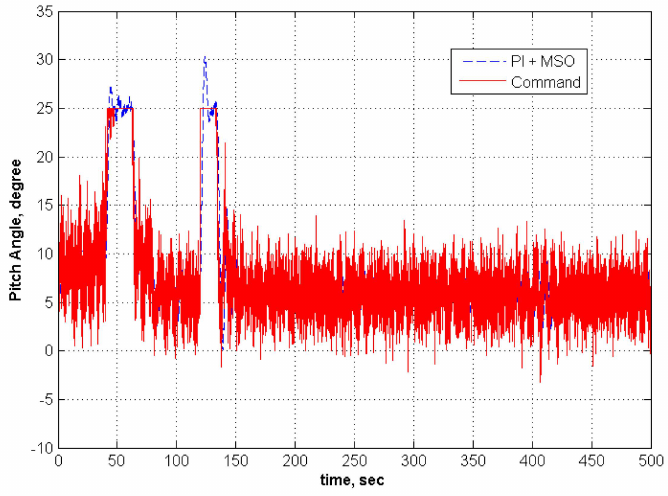
Figure 19. Pitch angle response for 50% C m α in the